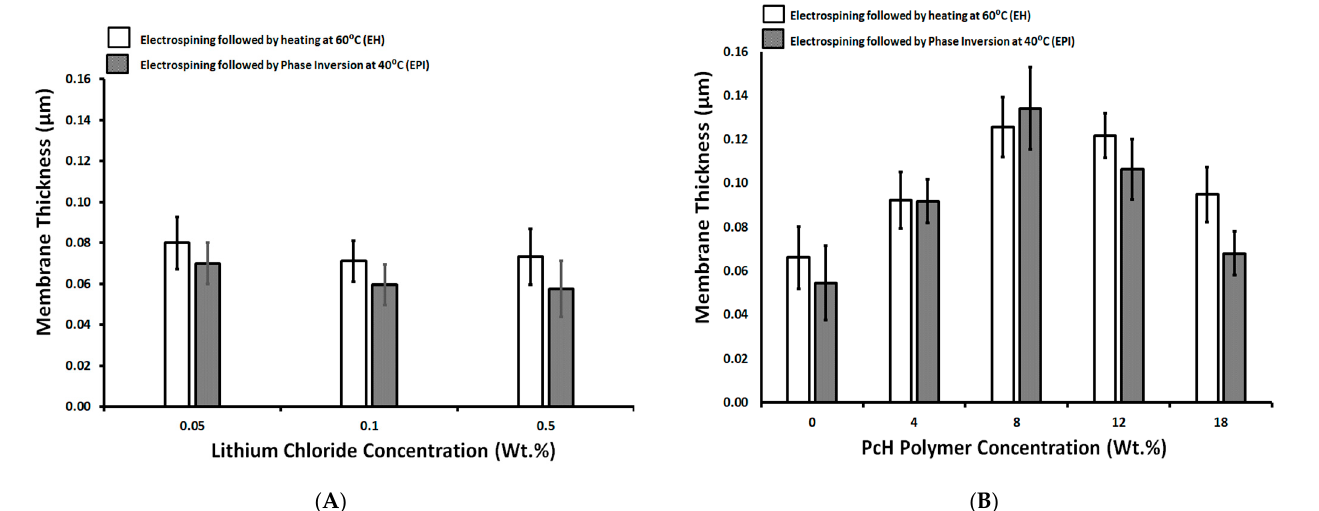
Figure 6. Surface roughness as a function of LiCl concentration (wt.%; A ) and as a function of PcH polymer concentration in the membrane dope (wt.%; B ).